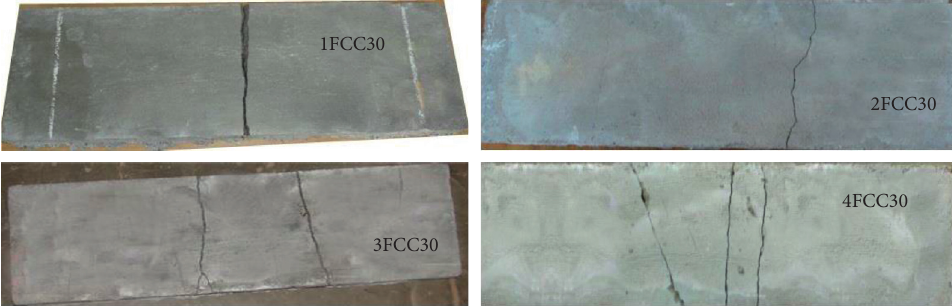
Figure 11: Crack pattern of ferrocement laminates under flexure.